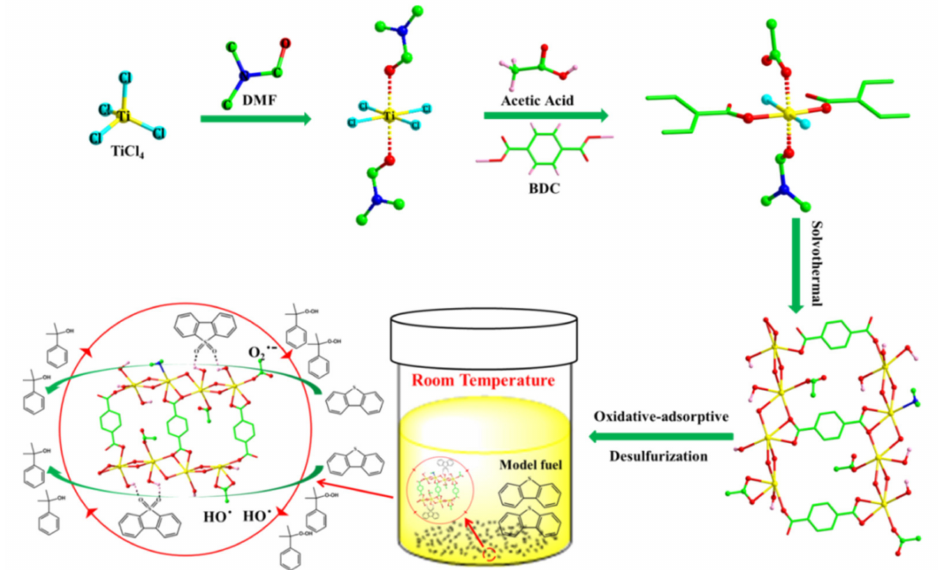
Figure 1. Imaginative diagram of the formation process of Ti-BDC-A and proposed reaction mecha- nism of the catalytic ODS of DBT over Ti-BDC-A (reproduced from Ref. [28], copyright 2020 American Chemical